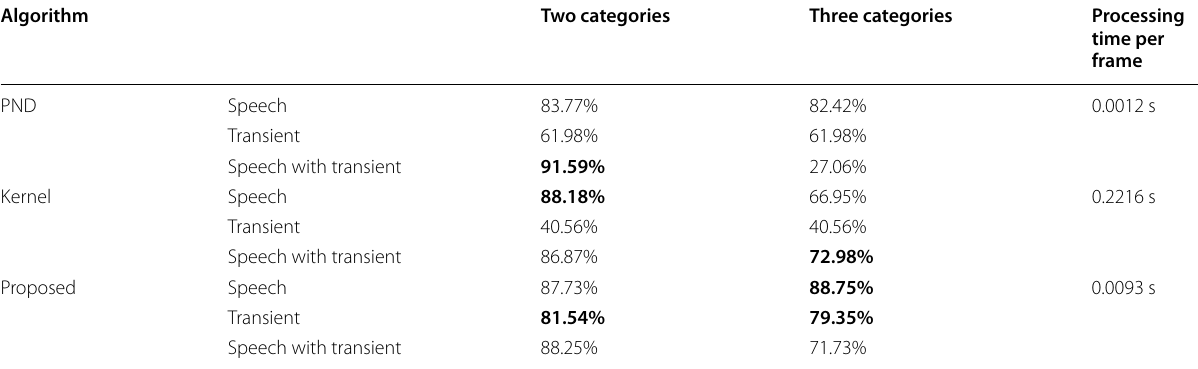
Note: Entries in boldface are the best